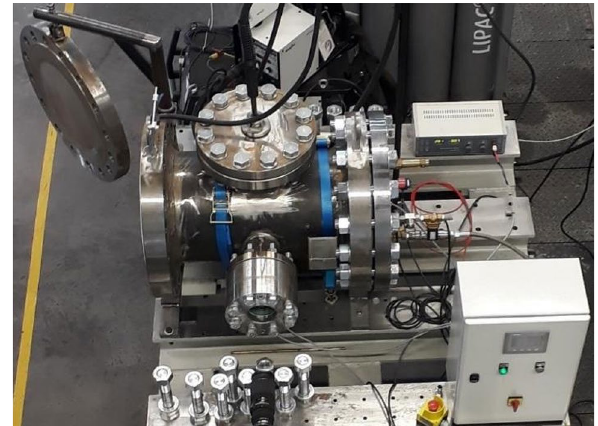
Figure 3. Welding chamber 17 .